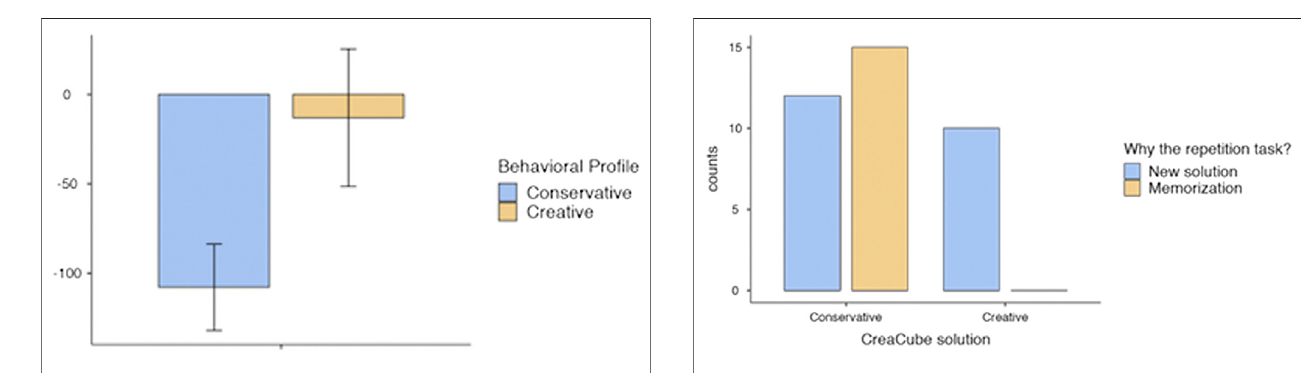
FIGURE 4 | Proportion of participants with regards to CreaCube task solutions and why the task was